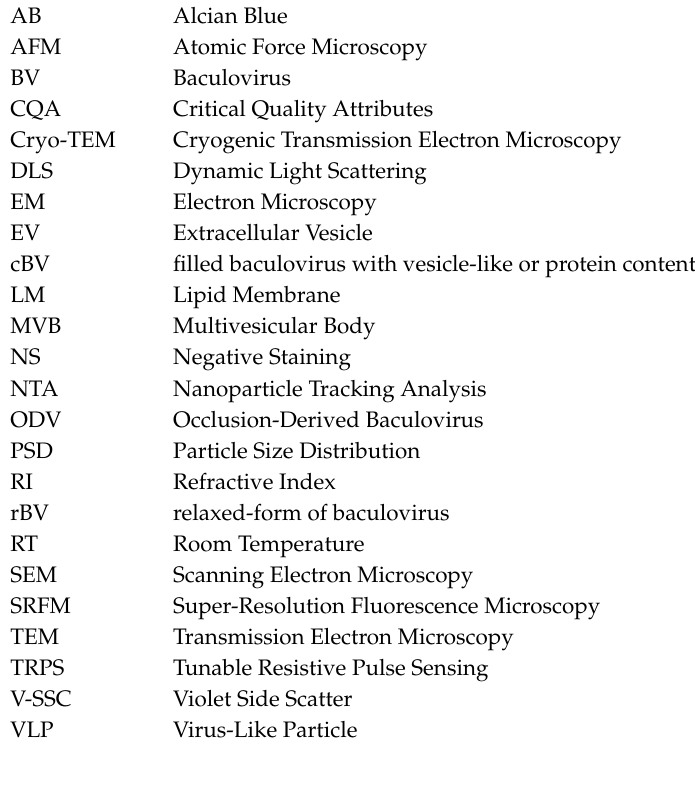
Figure S1: Negative control analyses: cell culture and conditioned media controls, Figure S2: Mie correlation for EV analysis with FCM PASS software, Figure S3: Nanoparticle correlation between flow virometry and